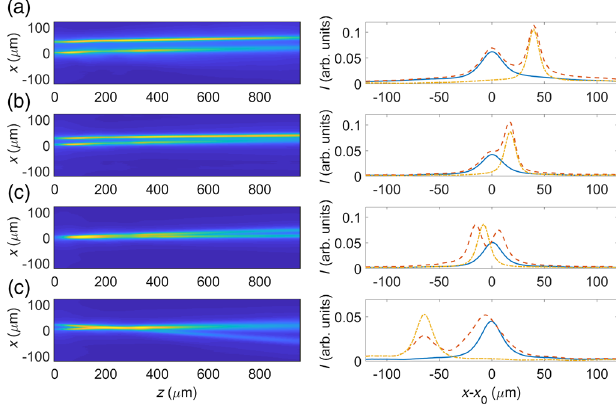
FIG. 8. Two-beam interaction in the presence of both the geometric and the dynamic phase. The input beams are the same as those launched in Fig. 7, but now a lower voltage of 2 V is applied to the sample [(a) – (c)]. The input powers are now (a) 5 and 4 mW, (b) 4 and 3 mW, (c) 8 and 7 mW, and (d) 7 and 6